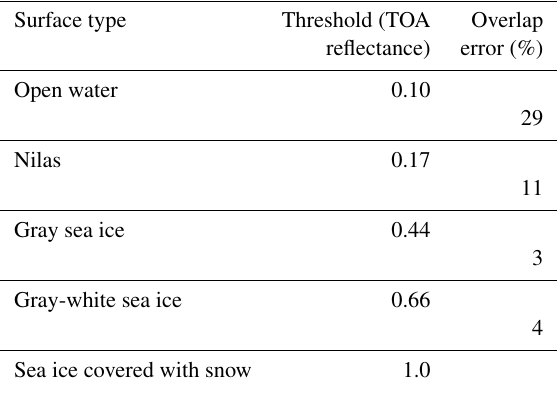
Table 2. The table displays the threshold for each surface type from the surface classification. The thresholds are the point of intersec- tion between the Gaussian curves describing the TOA reflectance values that occurred for each surface type (Fig. 3, Sect. 3.1). Every threshold contains the surface types that are above it in the table. Sea ice covered with snow has no estimated threshold; therefore it is indicated as